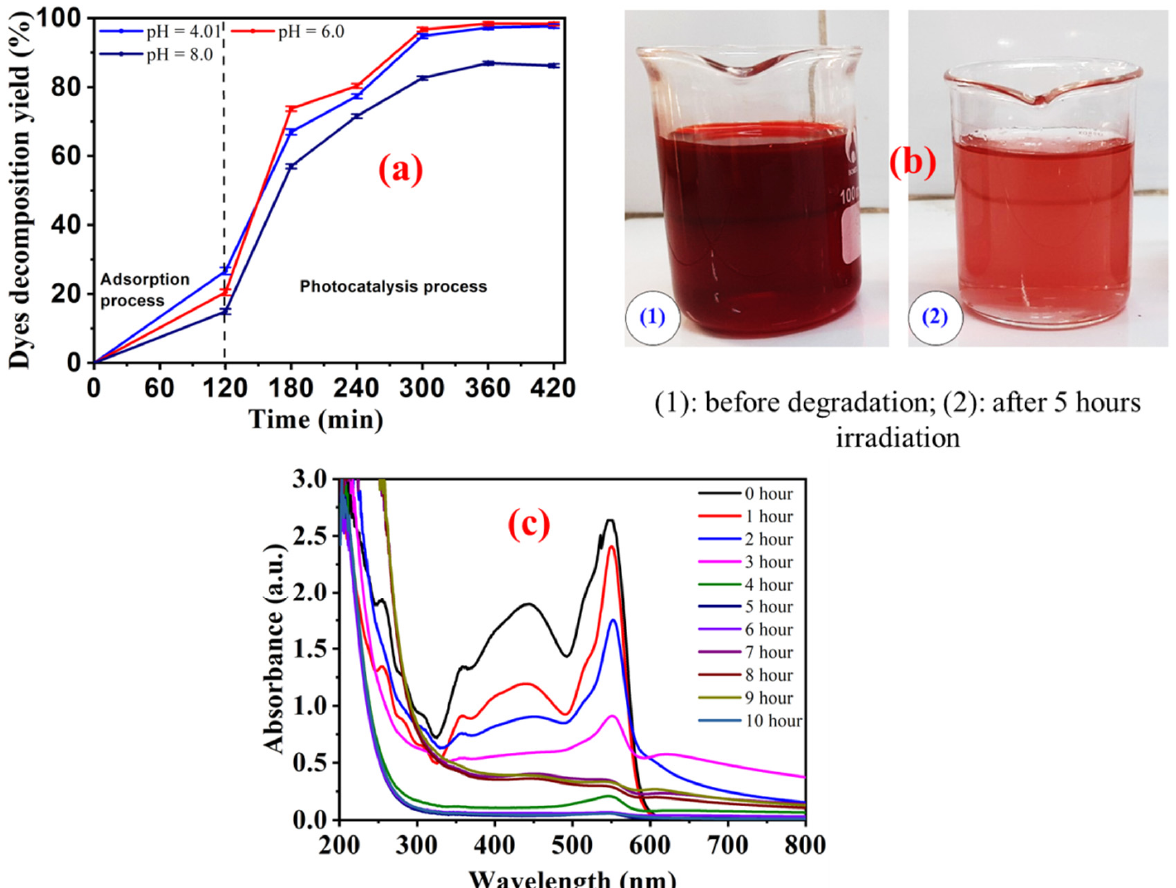
Figure 13. The efficiency of the dyes decomposition in sedge textile dyeing wastewater using CuH– 3.5 sample ( a ), visual properties of the dyes before degradation (1) and after five hours of irradiation (2) ( b ), UV–Vis spectra of dyes after ten hours of lighting by the 30 W LED at medium pH value as 6.0 ( c ).